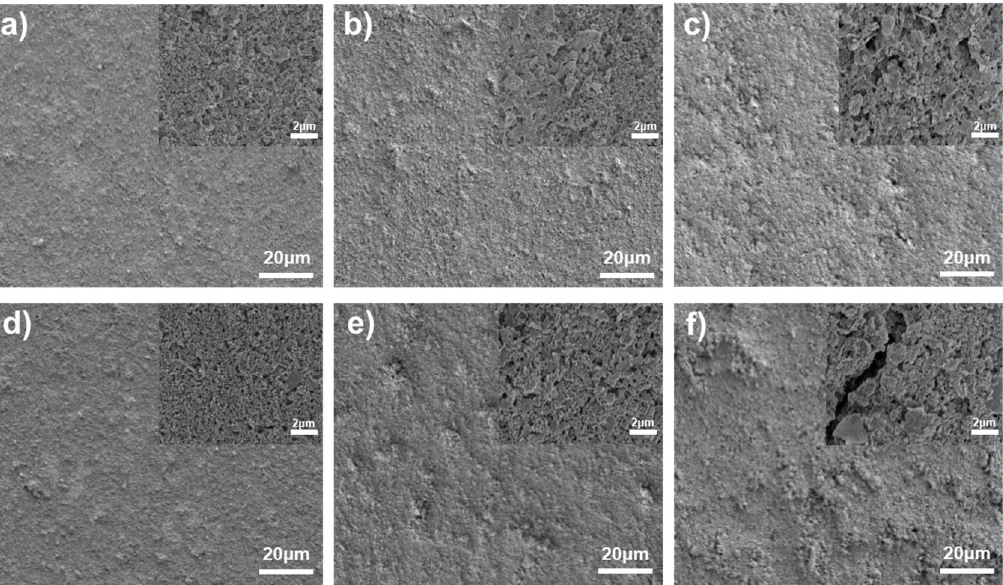
Figure 11. SEM images of h-BN coatings after dip-annealing treatment under different deposition conditions. ( a ) 15 V 10 min; ( b ) 30 V 10 min; ( c ) 50 V 10 min; ( d ) 30 V 8 min; ( e ) 30 V 12 min; ( f ) 30 V 16 min.